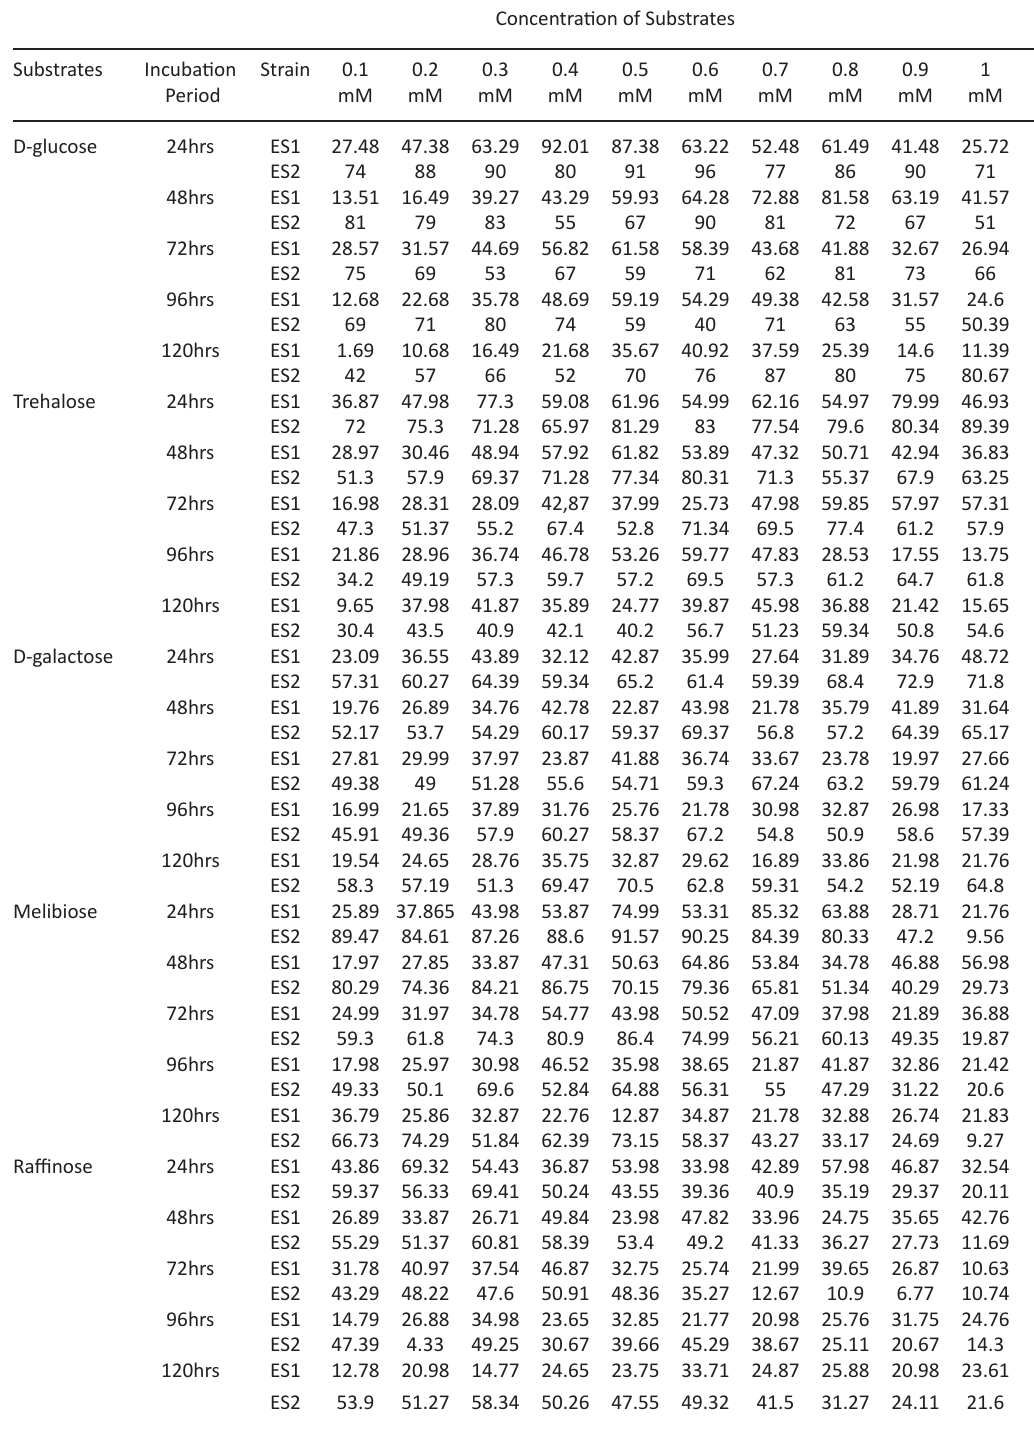
Concentration of Substrates